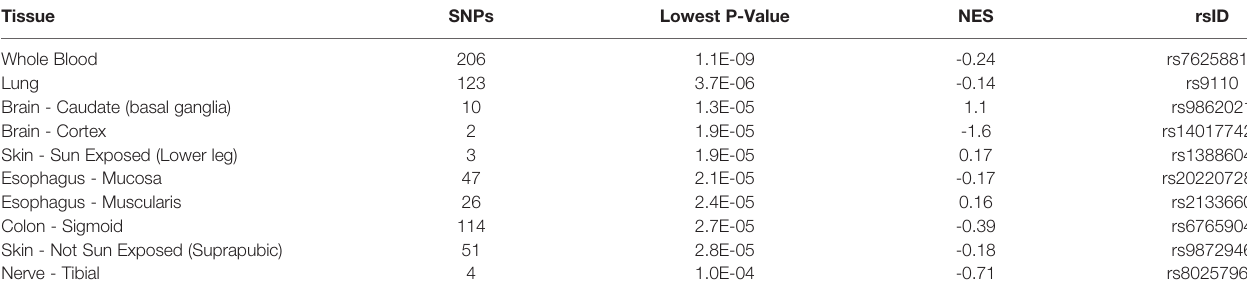
TABLE 3 | Top eQTL for CCR5 expression.